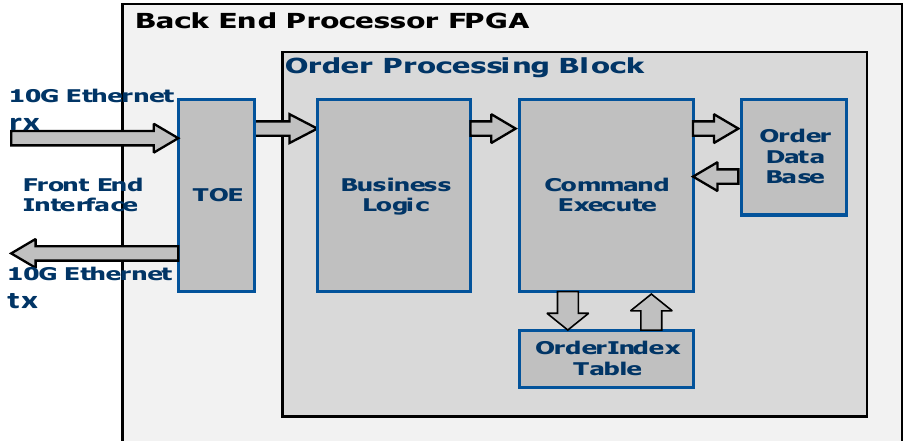
Figure 4. Block diagram of the back end processor FPGA.